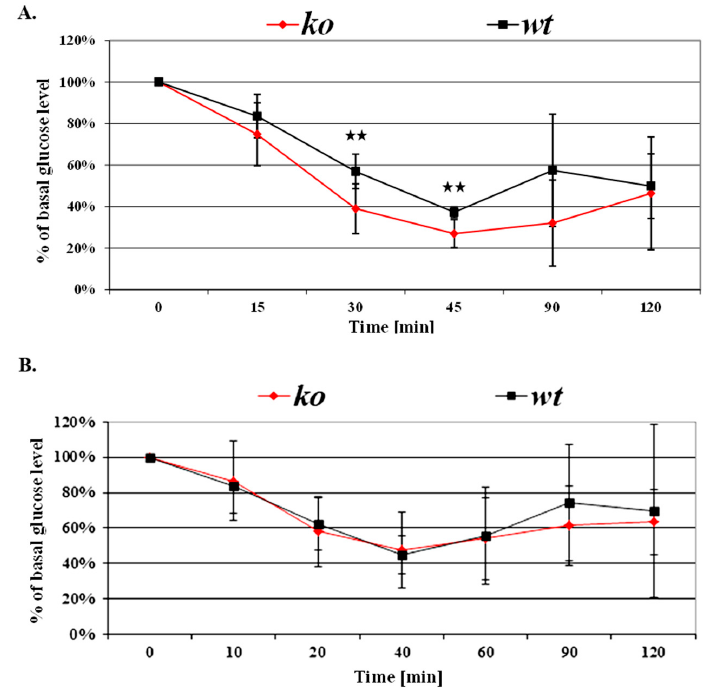
Figure 3. CD24 deficiency and insulin sensitivity. Insulin sensitivity of KO and WT males and females, aged 9–12 weeks, is presented in ( A , B ), respectively. Following intraperitoneal insulin injection (0.5 unit/kg body weight) of fasted mice, whole-blood glucose was measured at the indicated time points using a glucometer. Values are expressed as a percentage, relative to baseline glucose levels. Asterisks indicate statistically significant differences ( p < 0.05) between genotypes at each time point. Each value represents the average of at least three independent